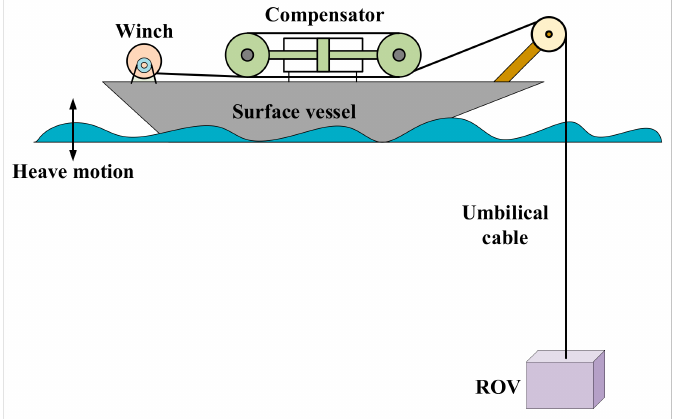
Figure 1. Active heave compensation for